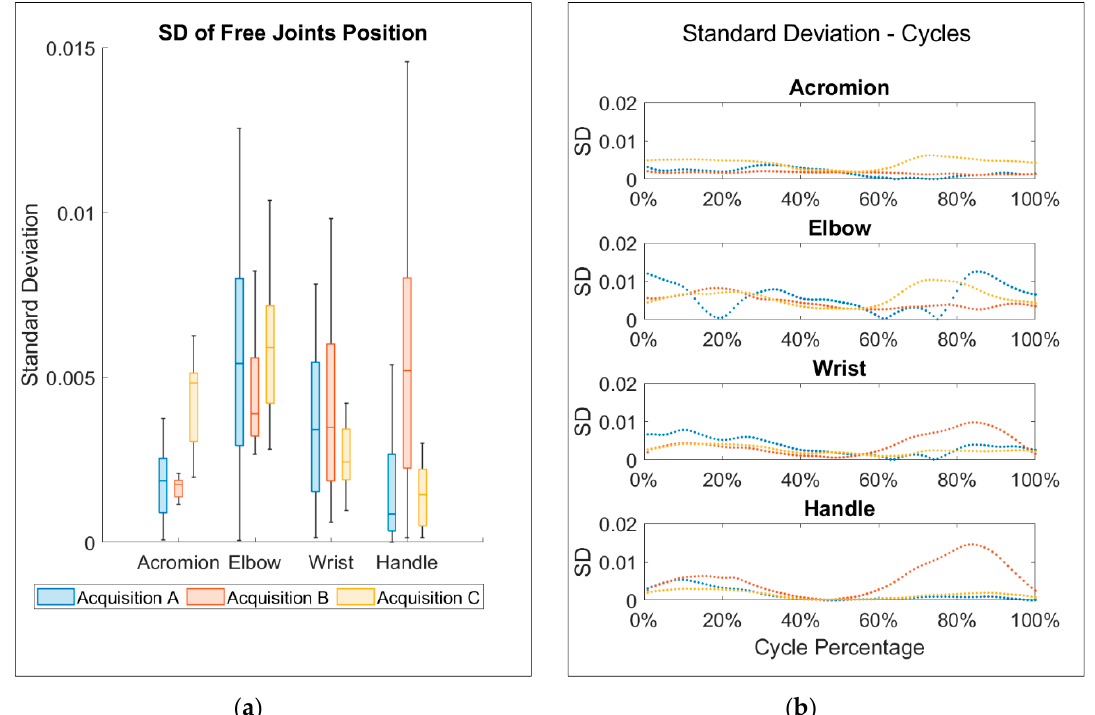
Figure 7. From the left, ( a ) standard deviation of the moving markers with respect to the cycle percentage, and ( b ) boxplot comparison of the same SD values. Blue for acquisition A, red for B, and yellow for C.